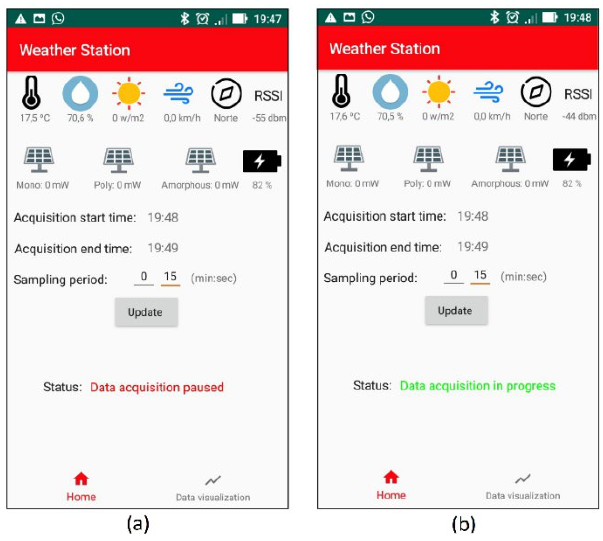
Figure 10. Home Fragment screen of the developed mobile app. (a) Before starting the acquisition. (b) After starting the